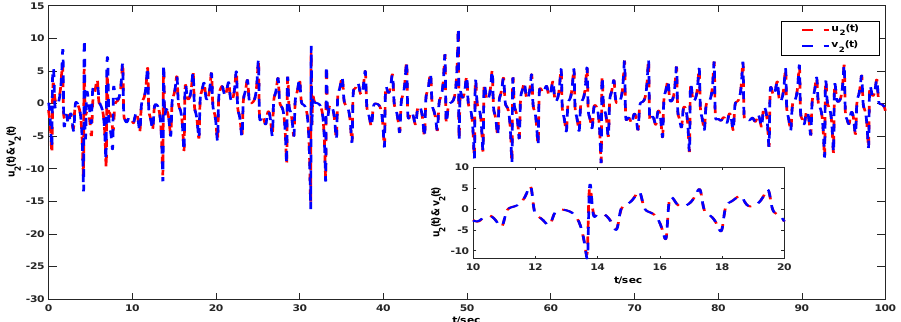
Figure 13. Synchronized time response of the states ( t , u 2 ( t )) and ( t , v 2 ( t )) of the drive-response systems (13) and (14) with fractional order q = 0.9.